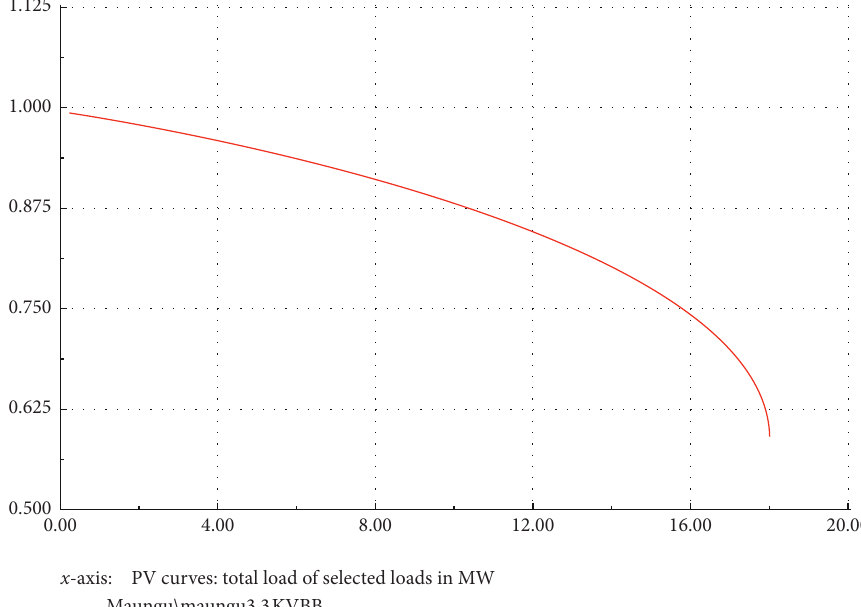
Figure 6: Maungu PV curve.